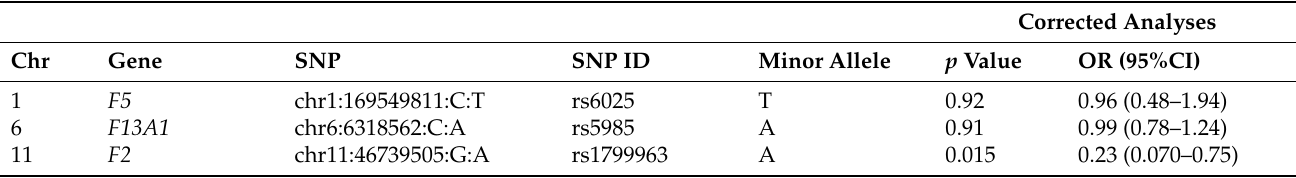
Corrected Analyses